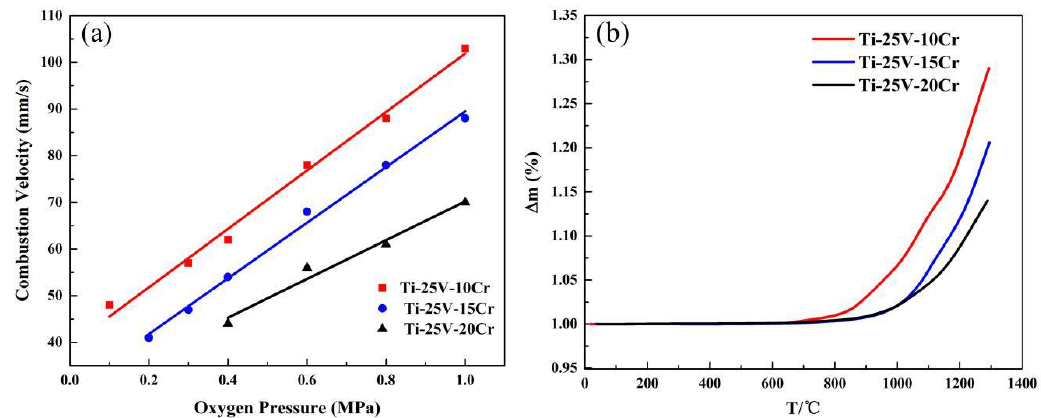
Figure 3. ( a ) The combustion velocity of specimens with the increasing oxygen pressures from 0.1 MPa to 1.0 MPa. ( b ) Mass gain curves of Ti-Cr-V alloys duo to non-isothermal oxidation from